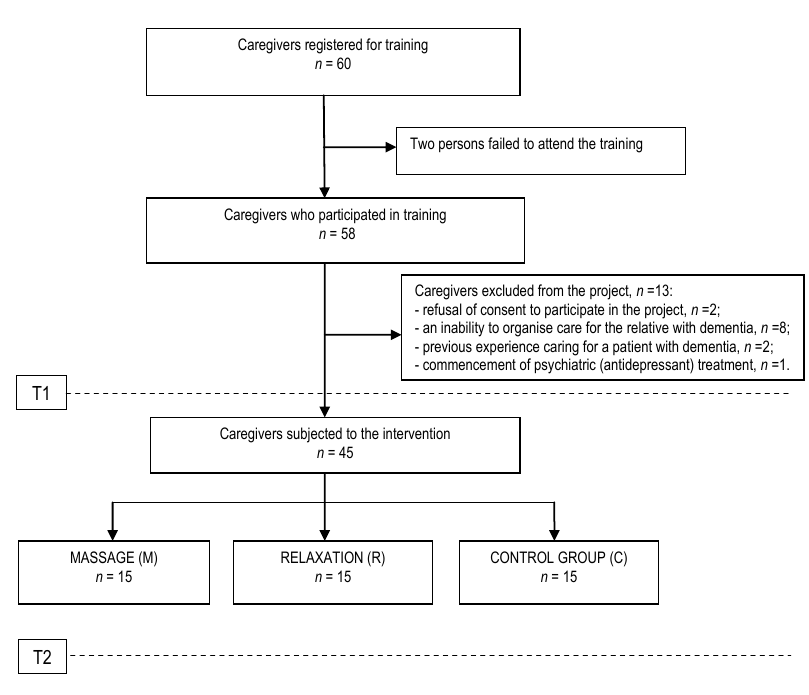
Figure 1. Study group